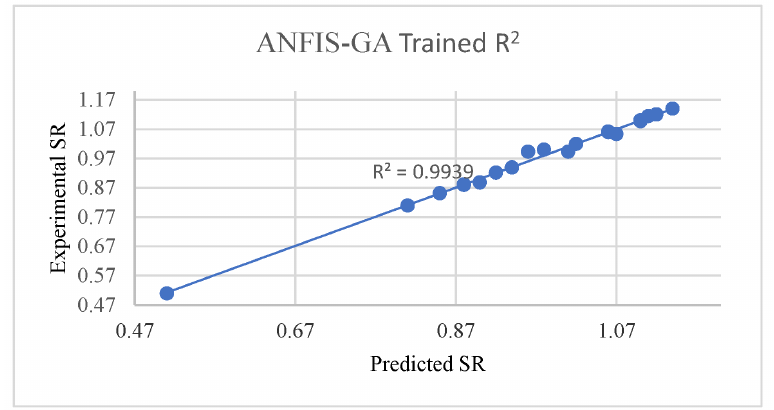
Figure 20 . ANFIS-GA training regression line .